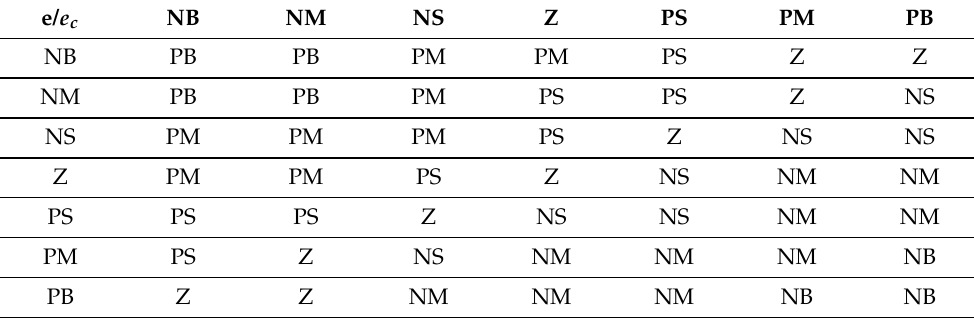
Table 2. K p fuzzy control